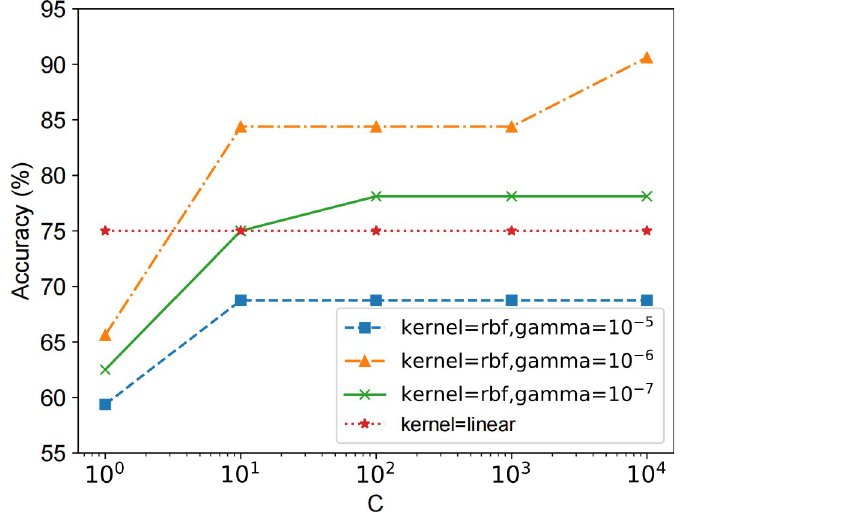
Fig 9. Accuracy of the SVM model using different hyper-parameters.